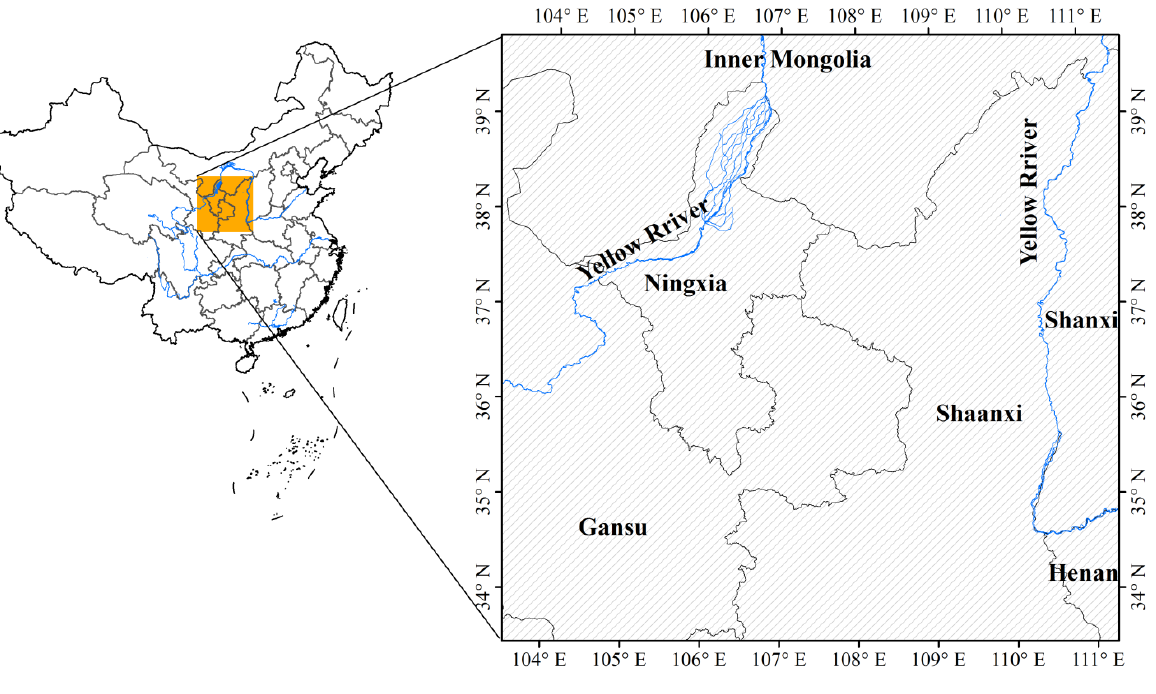
Figure 1. Location map of our study